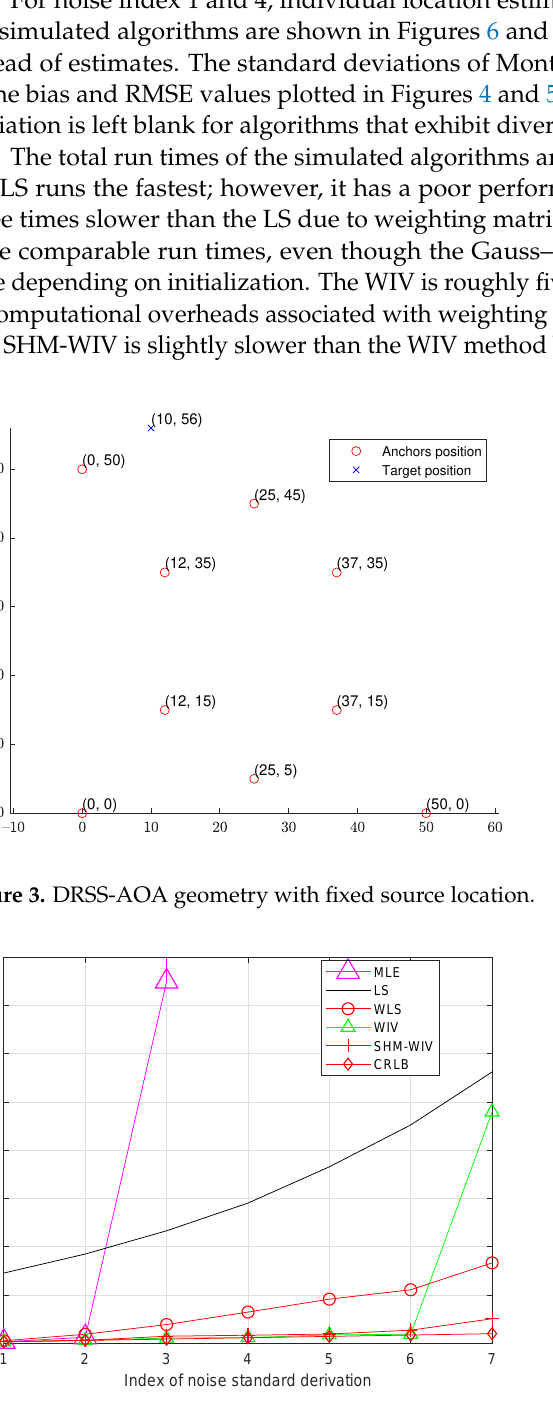
Figure 4. RMSE versus noise with fixed source